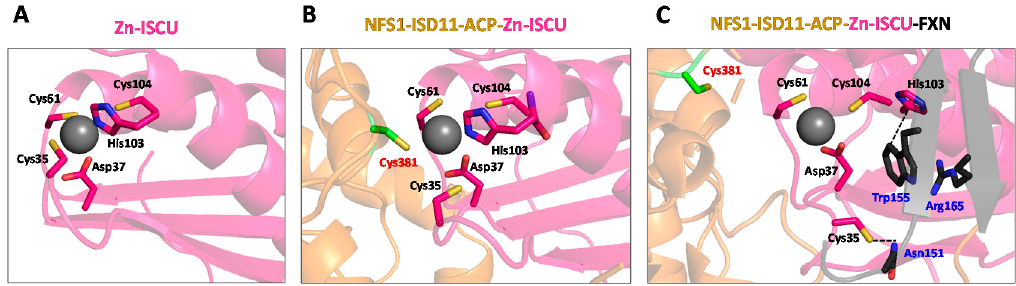
Figure 2. Structural rearrangement at the zinc site of ISCU upon binding of NFS1 and FXN. Zoom on the zinc site of ( A ) mouse ISCU (nuclear magnetic resonance (NMR) structure, PDB code 1WFZ) and in the human NFS1–ISD11–ACP–ISCU complex ( B ) without FXN (X-ray structure PDB code 5WLW) [67] and ( C ) with FXN (CryoEM structure PDB code 6NZU) [73]. ISCU and some of its key amino acids (Cys35, Asp37, Cys61 and His 103) are colored in pink, NFS1 is in yellow with its catalytic cysteine (Cys381) in green and FXN with its key amino acids (Asn151, Trp155 and Arg165) are in black. The dashed black line represents π staking between Trp155 and His103. The zinc ion is initially coordinated by Cys35, Asp37, Cys61 and His103 in ISCU. Upon binding to NFS1, the catalytic cysteine of NFS1, Cys381, binds to the zinc ion via exchange with Cys35. FXN binds to the NFS1–ISD11–ACP–ISCU complex and pushes aside His103 and Cys35 of ISCU via interactions with Trp155 and Asn151, respectively, thereby uncovering Cys104.